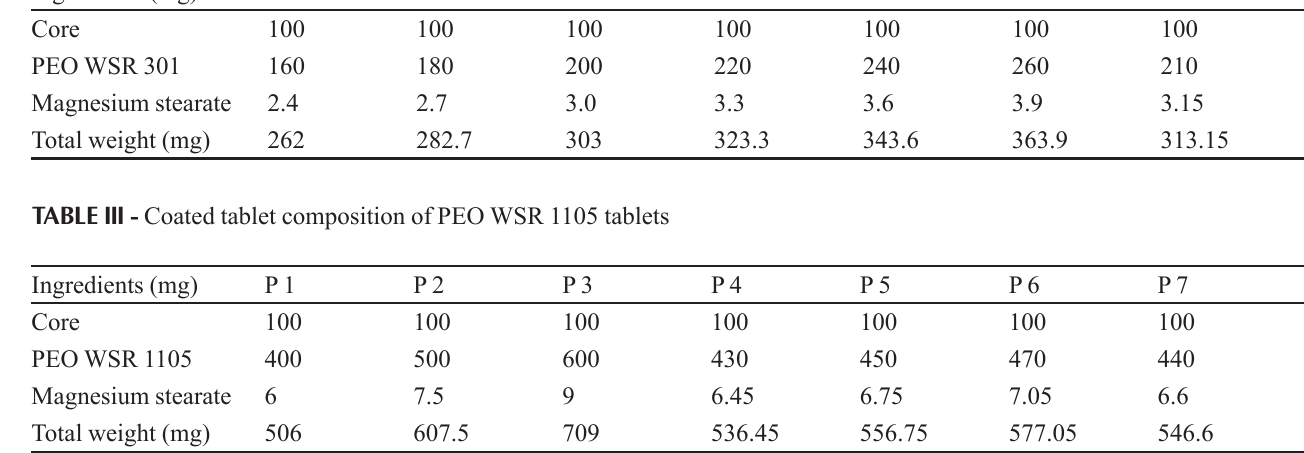
TABLE II - Coated tablet composition of PEO WSR 301 tablets Ingredients (mg)